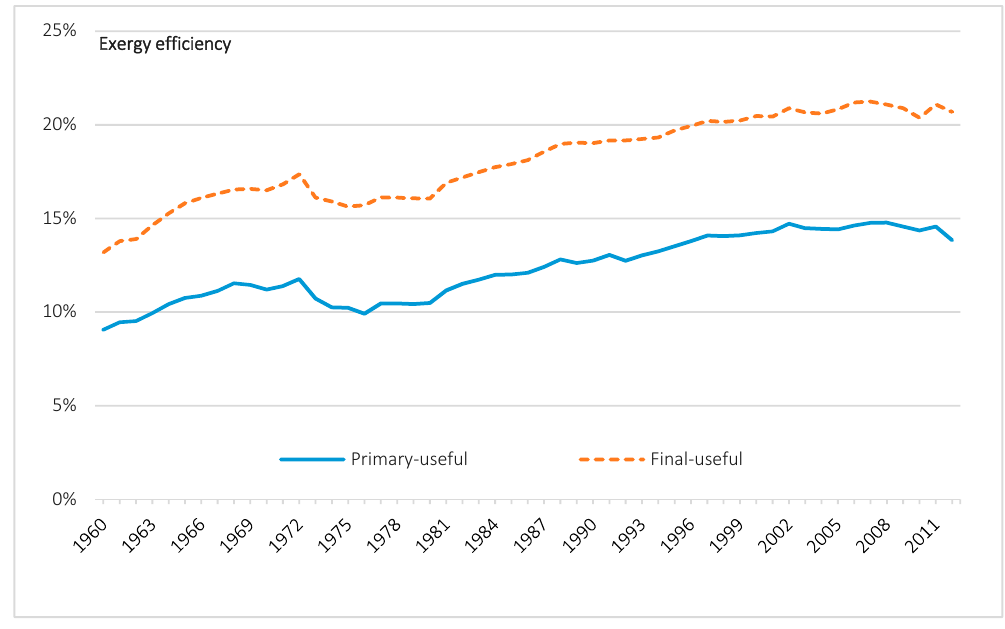
Figure 2. UK national-level exergy efficiency on a primary to useful, and final to useful basis. Useful exergy outputs are estimated using base methods (see Section 3.2) and primary exergy inputs are estimated using resource content method (see below).